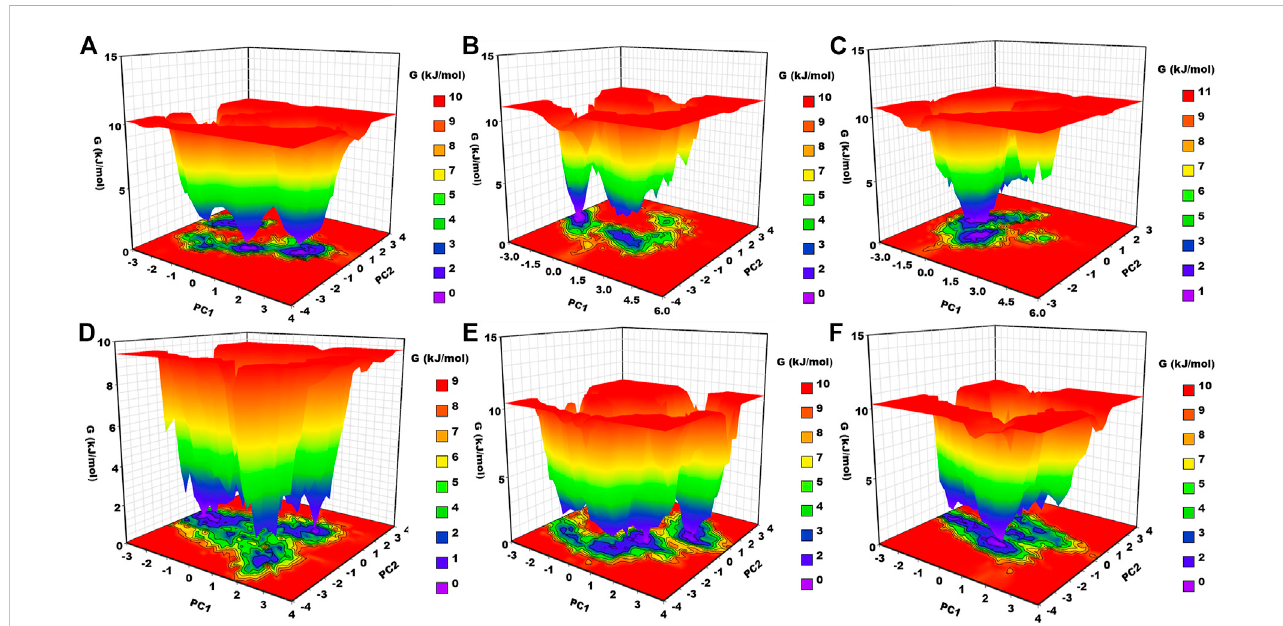
FIGURE 8 Gibbs free energy landscape. (A) apo – DYRK1A, (B) DYRK1A – 4E3, (C) DYRK1A – ZINC2123081, (D) DYRK1A – ZINC3843365, (E) DYRK1A – ZINC5220992, and (F) DYRK1A –